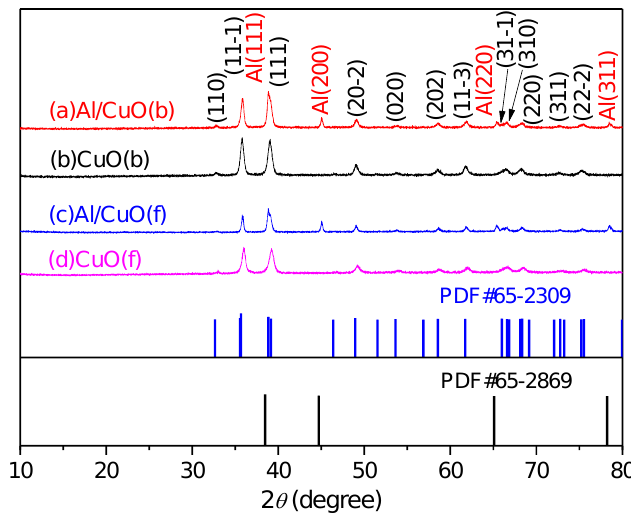
Figure 5. X-ray diffraction (XRD) patterns of different CuO and Al/CuO nanothermites. ( a ) Al/CuO(b); Figure 5. X-ray di ff raction (XRD) patterns of di ff erent CuO and Al / CuO nanothermites. ( a ) Al / CuO(b); ( b ) CuO(b); ( c ) Al/CuO(f); and, ( d ) CuO(f). ( b ) CuO(b); ( c ) Al / CuO(f); and, ( d )